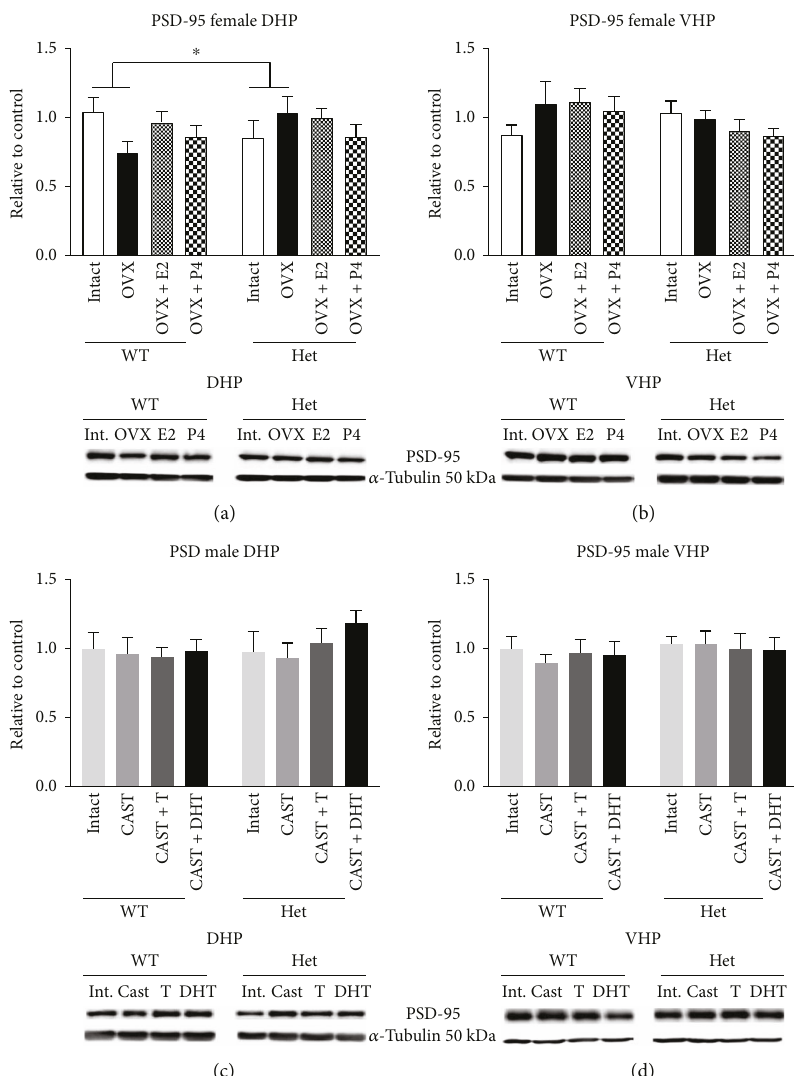
Figure 4: Protein expression of PSD-95 in the dorsal (a) and ventral (b) hippocampus of female sham ovariectomized+ placebo (intact), ovariectomized+ placebo (OVX), OVX+ estradiol (E2), and OVX +progesterone- (P4-) treated mice. Protein expression of PSD-95 in the dorsal (c) and ventral (d) hippocampus of male sham castrated +placebo (intact), castrated+ placebo (CAST), CAST +testosterone (T), and CAST +dihydrotestosterone- (DHT-) treated mice. N =5 – 7 per treatment group. ∗ p < 0 05 . Error bars represent the standard error of the mean (SEM). Bars with connecting horizontal lines show signi fi cant interactions (OVX ×